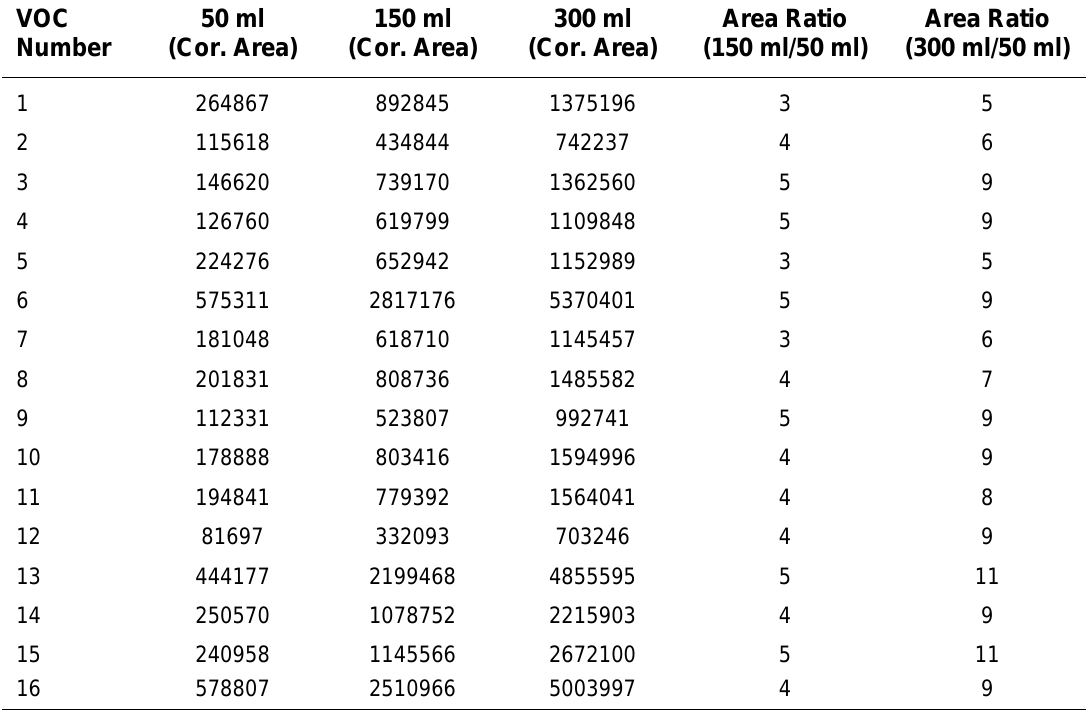
Comparison of Several VOC Peak Areas at Different Preconcentration